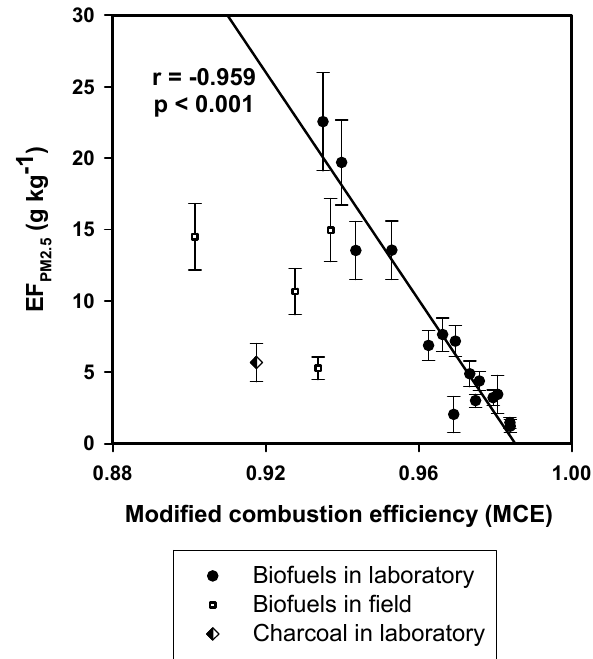
Figure 5. A scatterplot of MCE vs. EF PM , with the regression 2 . 5 line applied only to the biofuel samples in the laboratory combus- tion tests. Excluded from this regression were charcoal burning, bio- gas, and the very high EF PM for the three-stone fire fueled with 2 . 5 dung (see Sect. 3.7). The field tests consistently fall below the re- gression line, indicating that biomass burning measured in the field is generally lower in MCE compared to the laboratory measure-